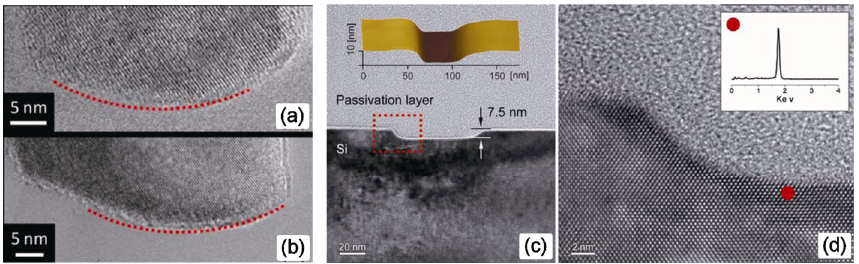
Fig. 10 (a, b) High-resolution TEM images of worn tips without sub-surface damage because of tribochemical wear after removal of material. Reproduced with permission from Ref. [112], © Nature 2013. (c) High-resolution TEM images showing an approximately 7.5-nm deep tribochemical wear scar formed on silicon surface after sliding against a SiO 2 microsphere under conditions of P = ~1.3 GPa, RH = 60%, v = 24 µm/s, and N = 100. Inset shows AFM image of wear scar. (d) Representative lattice-resolved image in worn area marked with box (red dotted line) in (c). EDX spectrum in inset reveals no oxygen is detected in sub-surface of silicon. Reproduced with permission from Ref. [113], © American Chemical Society